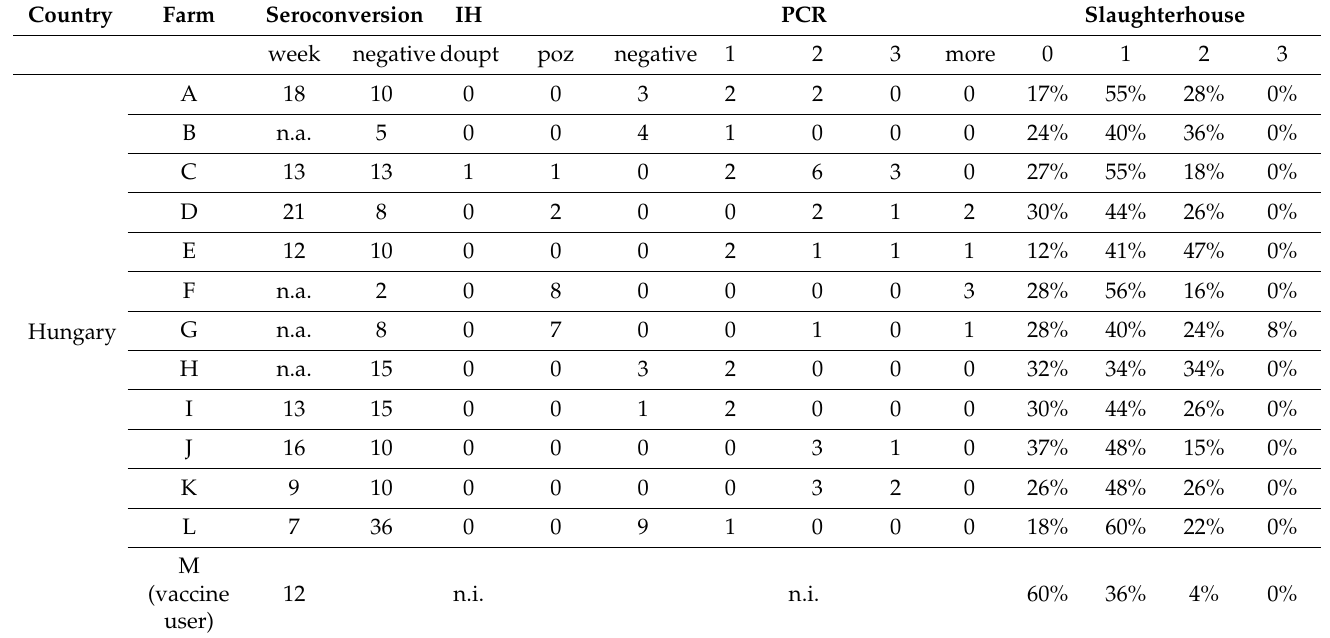
Table 8. Serology, PCR, and VP